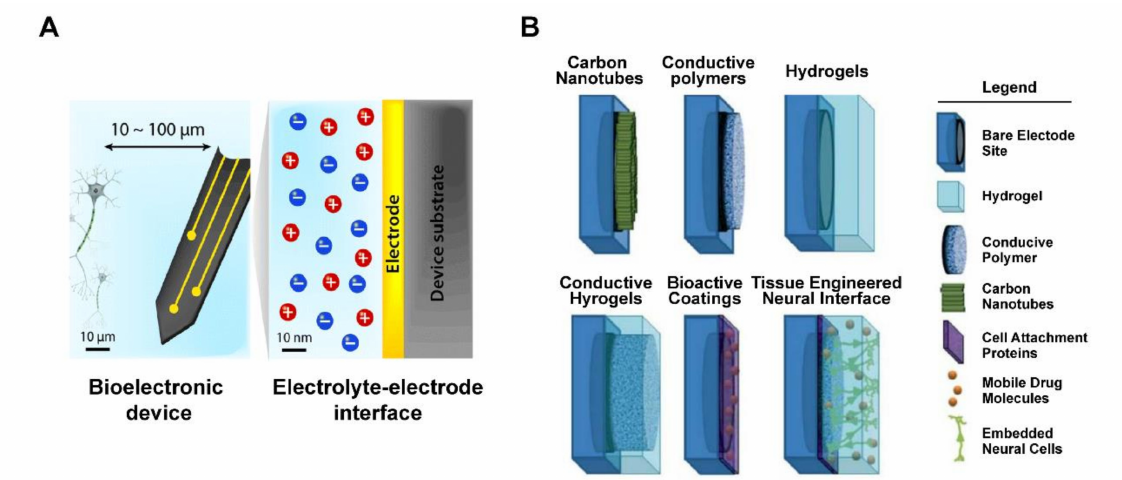
Figure 4. Schematic of tissue–electrode interfaces. ( A ) The electrodes of bioelectronic devices are usually implanted within 100 µ m of the target tissue, and exchange of electronic signals occurs at a nanoscale electrolyte–electrode interface. Adapted with permission from Hyunwoo et al. [55]. ( B ) Application of various non-metallic material coating technologies as electrode interface, includes bare electrode